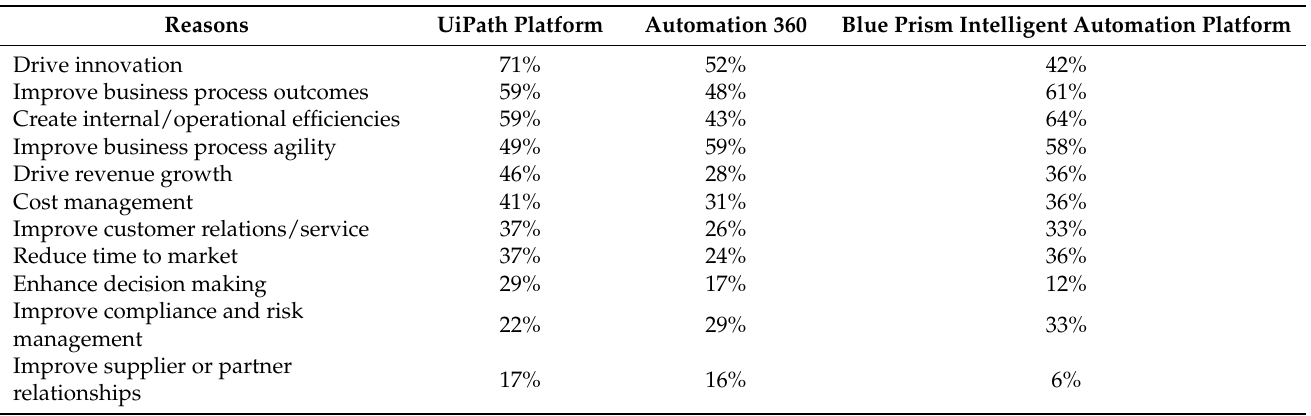
Table 6. Reasons for purchasing a product/service.